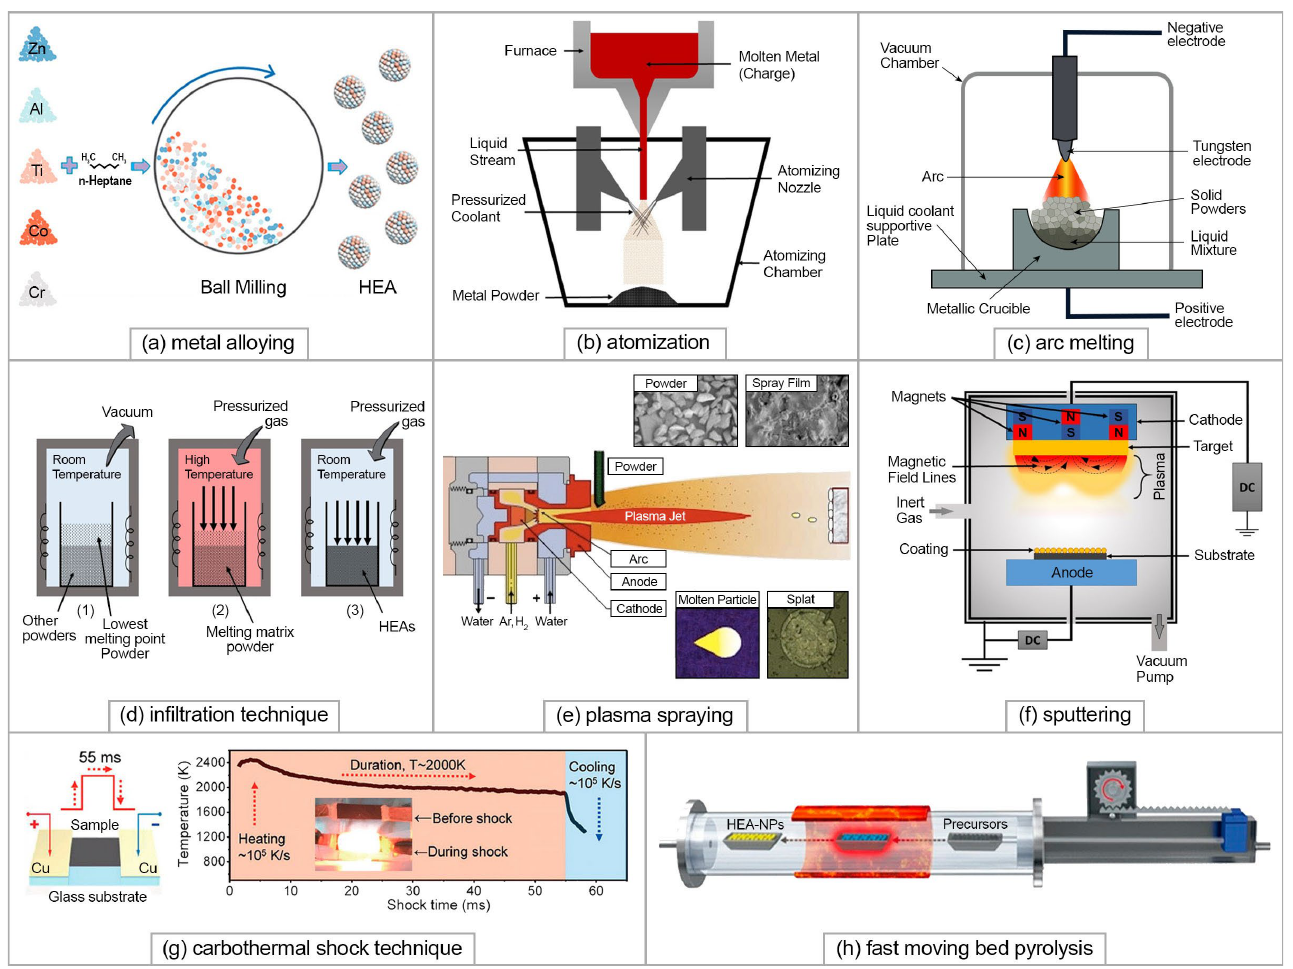
Figure 4. HEA synthesis methods: ( a ) metal alloying; ( b ) atomization; ( c ) arc melting; ( d ) infiltration; ( e ) plasma spraying; ( f ) sputtering; ( g ) carbothermal shock technique; ( h ) fast-moving bed pyrolysis (( a , g , h ) are reprinted with permission from [28], Copyright (2020) American Chemical Society; ( b , d , f ) are reproduced from [50] with permission of Springer Nature; ( e ) is reproduced from [51] with permission of the Royal Society of Chemistry).